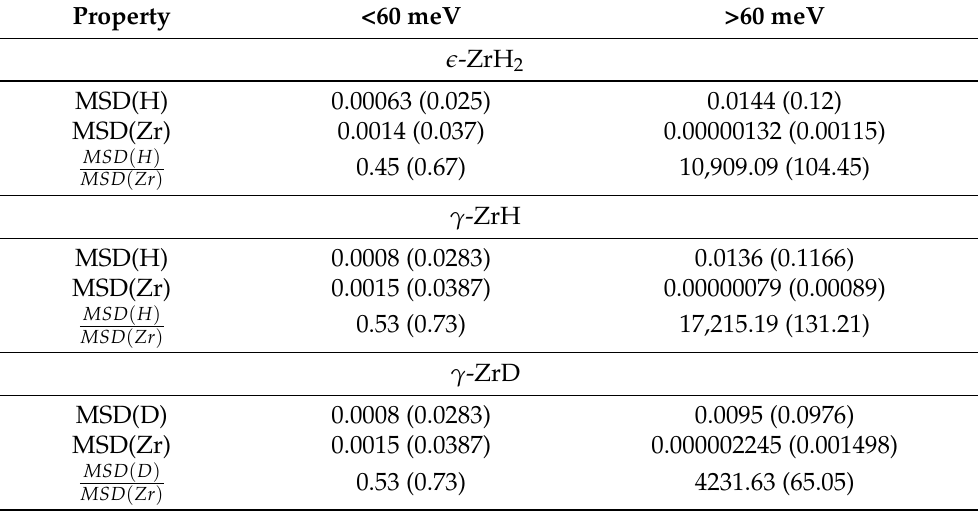
√ MSD (in brackets) of Zr at (0, 0, 0) and H(D) at ( 3/4,1/4,3/4 ) Table 1. The calculated MSD and √ MSD . In γ -ZrH( γ -ZrD), for ZrH x in different energy ranges. Units are in Å 2 for MSD and Å for MSD(Zr) varies slightly (within 3%) between different Zr